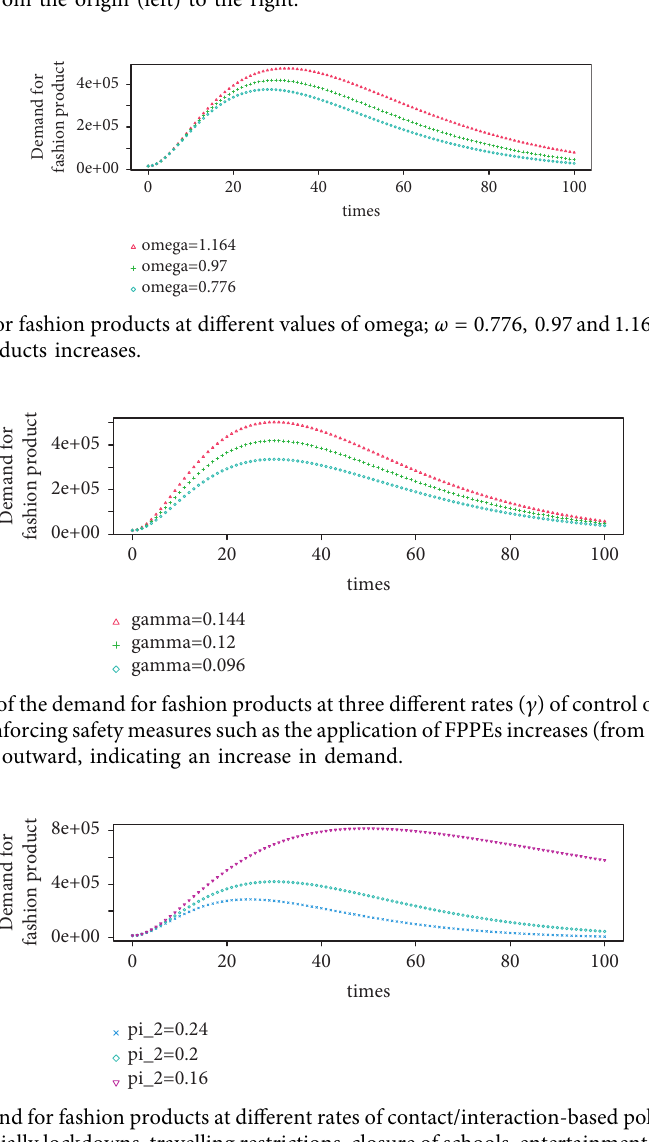
. As μ increases, the demand for 1 1